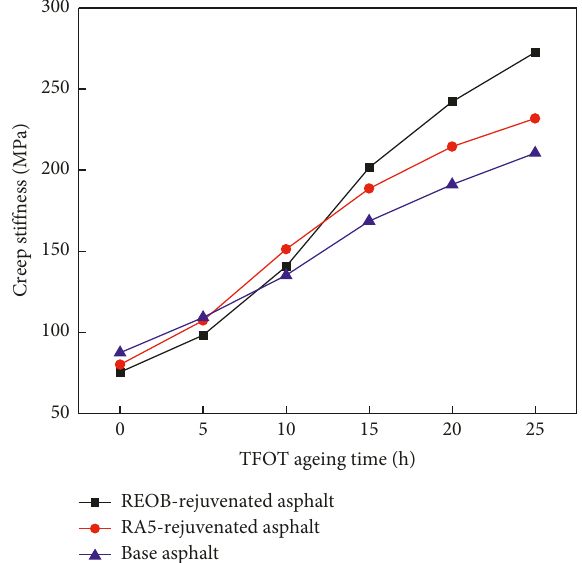
Figure 5: Relation between creep stiffness rate and TFOT ageing time.